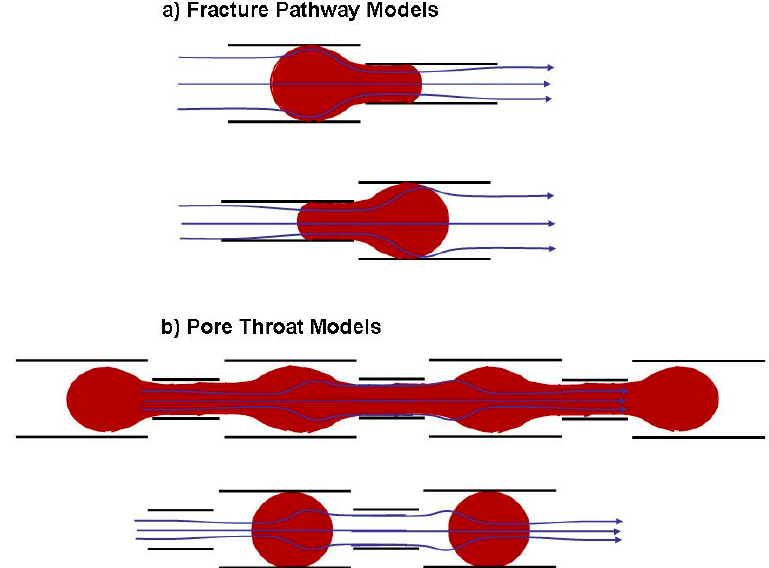
Figure 17. Principal sketches of non-wetting phase (e.g., oil, red) in interfacial contact with wetting phase (water or gas). ( a ) Fracture model shows a fracture space widening downstream (top) and narrowing (bottom). ( b ) Pore throat model showing stretching of oil ganglion during flow (top) and snapping into oil drops due to capillary forces when flow slows (bottom).